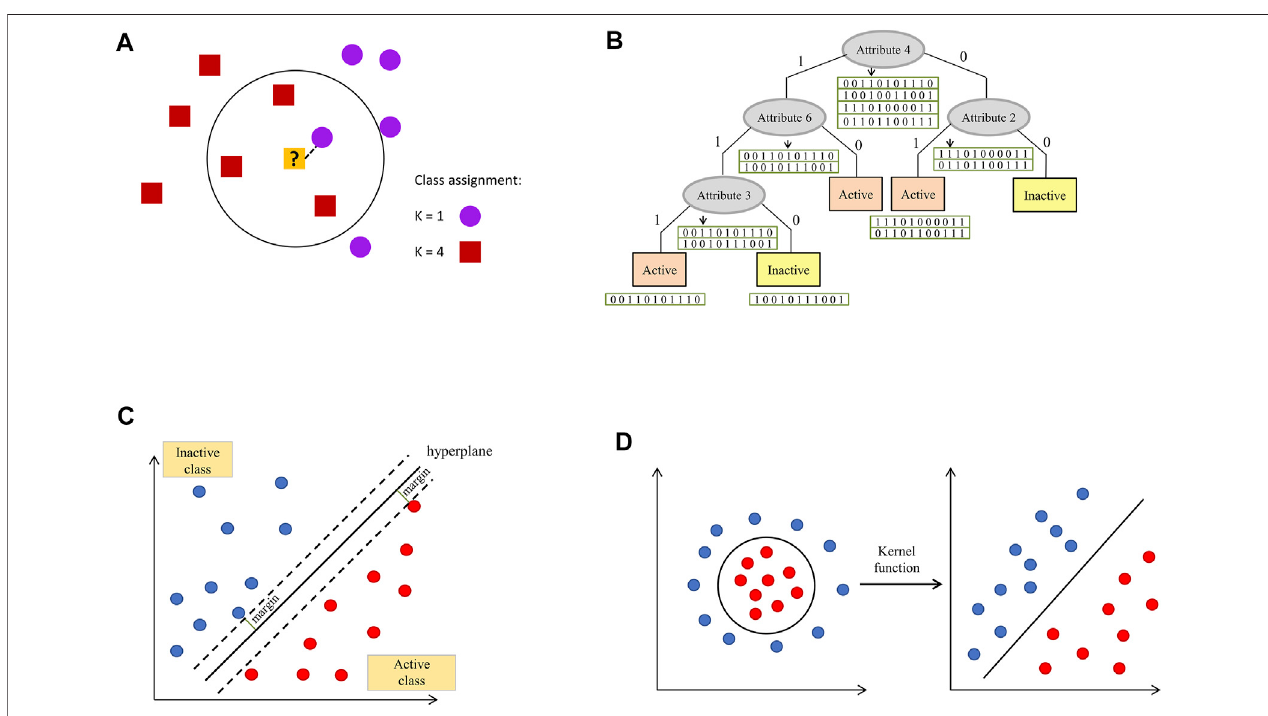
FIGURE2| VisualizationofselectedMLalgorithms: (A) k-nearestneighbor, (B) decisiontree, (C) hyperplanewiththehighestseparationmarginconstructedwithin the support vector machines algorithm implementation, (D) data transformation to the space, in which they are linearly separable with the use of the kernel function.